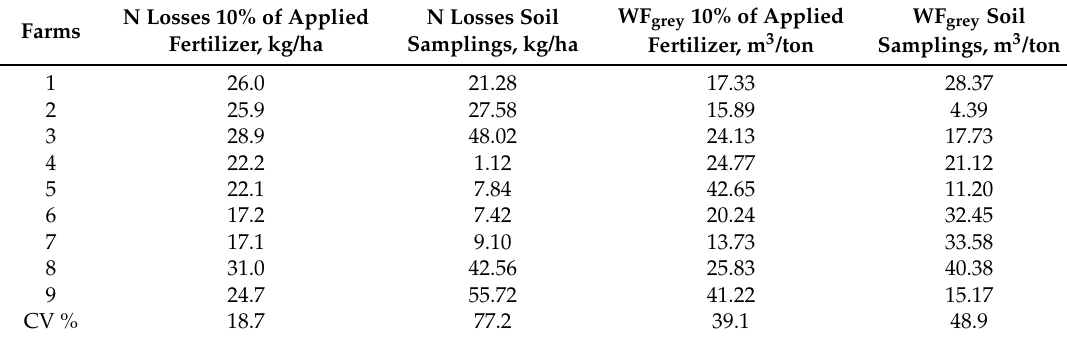
Table 5. N losses and resulting WF grey according to the method used for N losses estimation. Farms